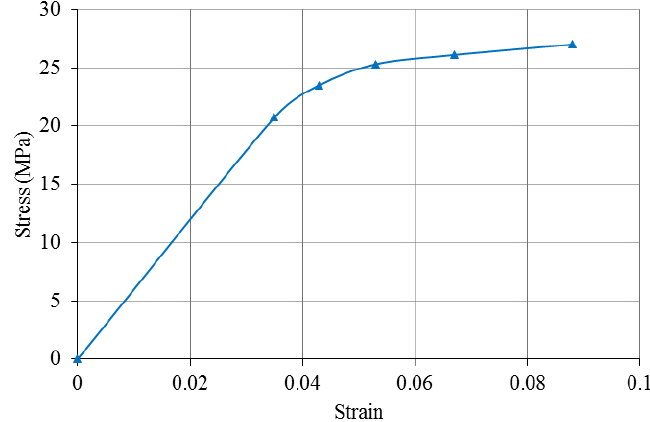
Figure 4. Stress versus strain curve for the polymeric material [36].